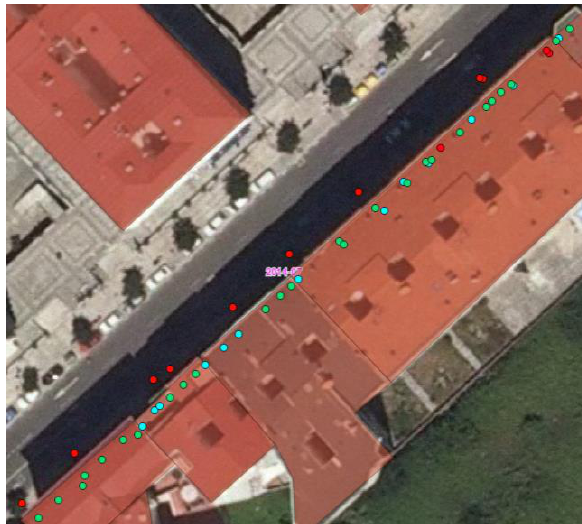
Figure 14. Location of step and ramp entrances. Colour code: buildings in semi-transparent red, step entrances in green, ramp entrances in blue and tree gratings and entrance errors in